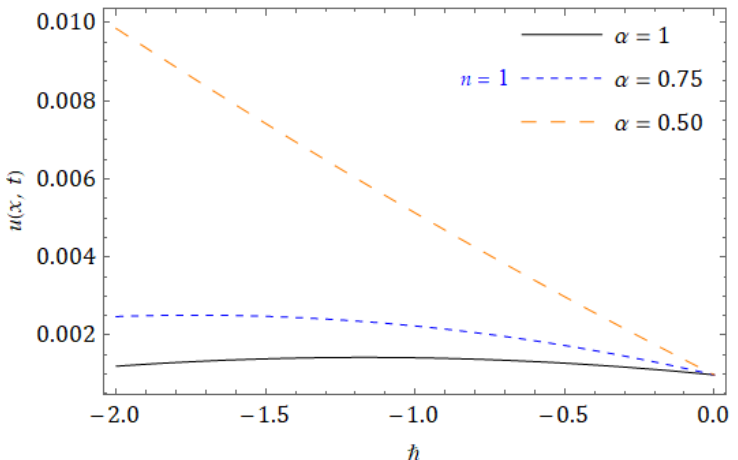
= 1, t = 0.01, (cid:125) = − 1, β = 1, κ